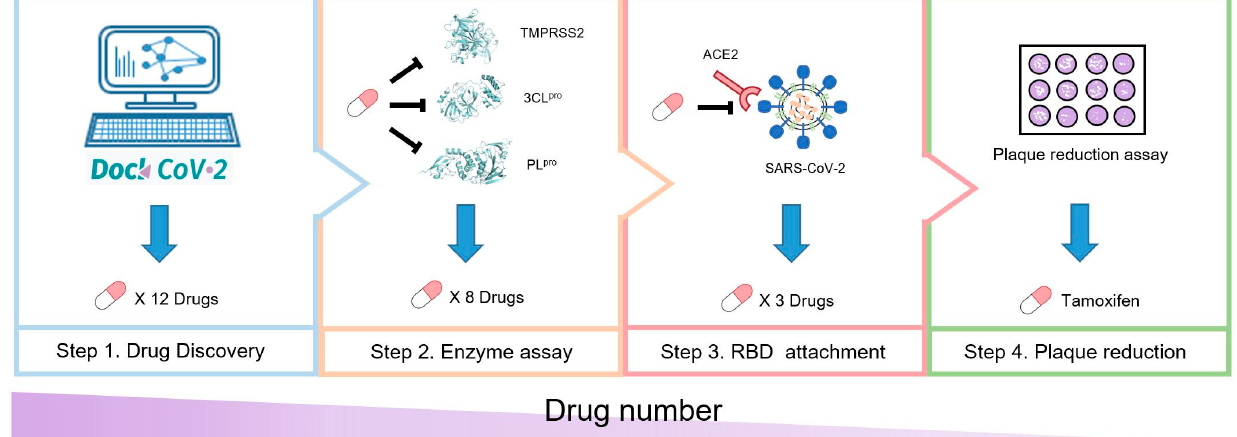
Figure 1. Study overview. A schematic of our anti-SARS-CoV-2 compound screening process. The anti-SARS-CoV-2 potential of 12 compounds was first analyzed through molecular docking using DockCoV2. Next, the inhibitory effect of those compounds on TMPRSS2, 3CL pro , and PL pro was tested. The RBD attachment assay indicated the ability of the compound to block the interaction between the spike RBD and ACE2. Finally, the plaque reduction assay revealed the antiviral activity of the compounds.